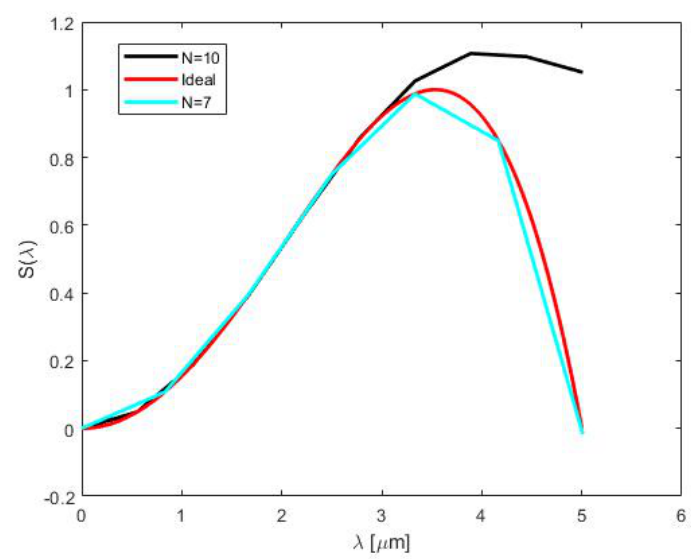
Figure 3. Spectral response function reconstruction with power series.